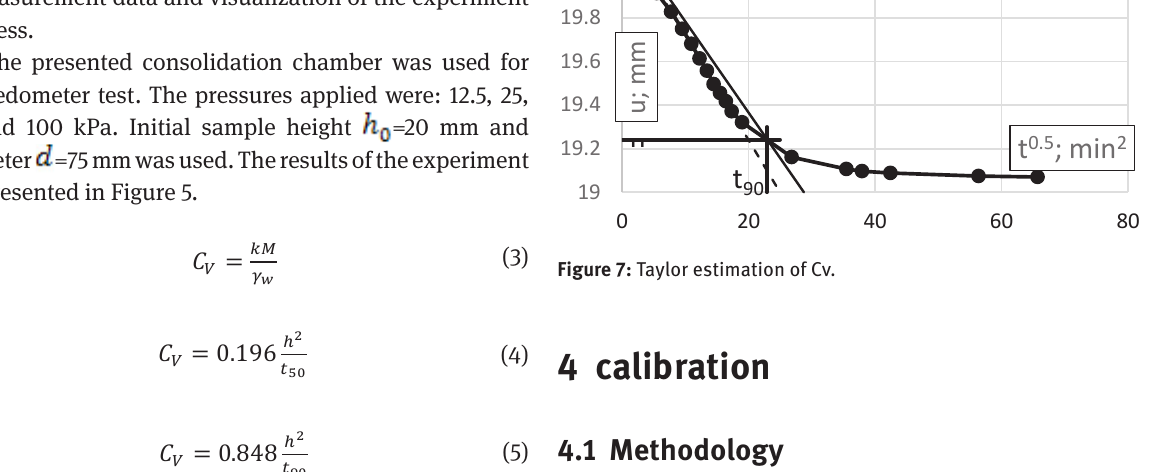
Figure 6. Cassagrande estimation of Cv Figure 7. Taylor estimation of Cv Figure 7. Taylor estimation of Cv Figure 7. Taylor estimation of Cv